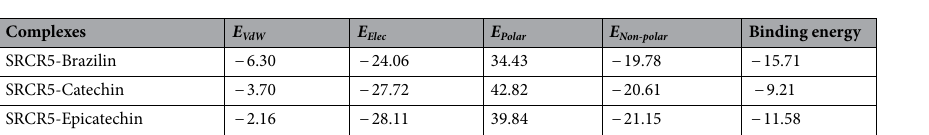
Table 1. Binding energy components of bound SRCR5 forms obtained from the molecular mechanics Poisson-Boltzmann surface area method (MM-PBSA). All energy terms are represented in kcal/mol unit.